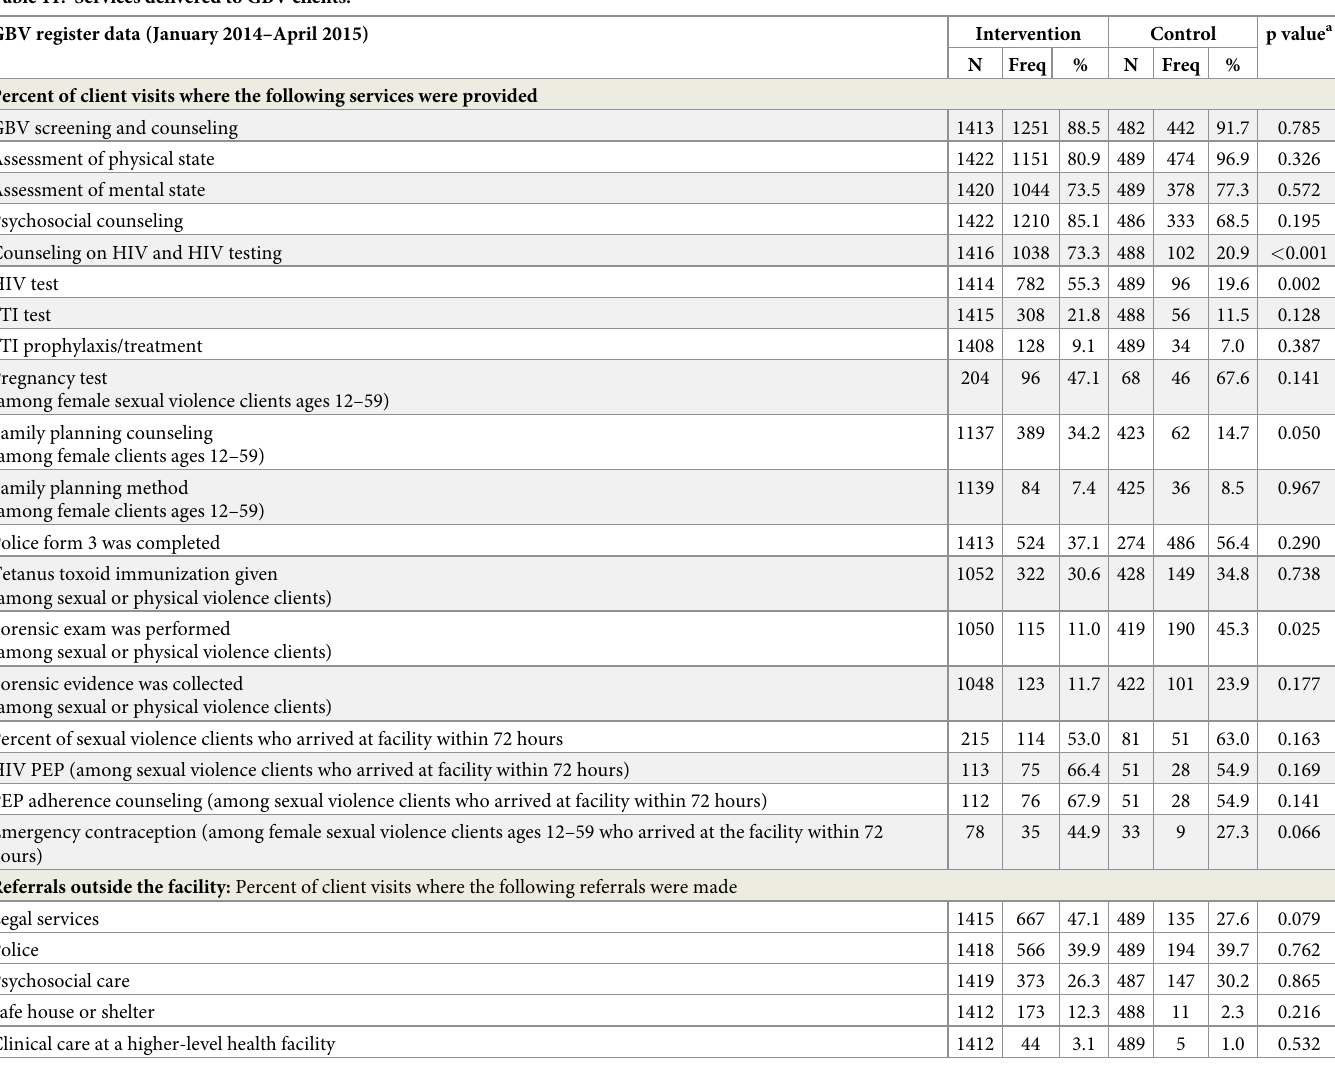
Table 11. Services delivered to GBV